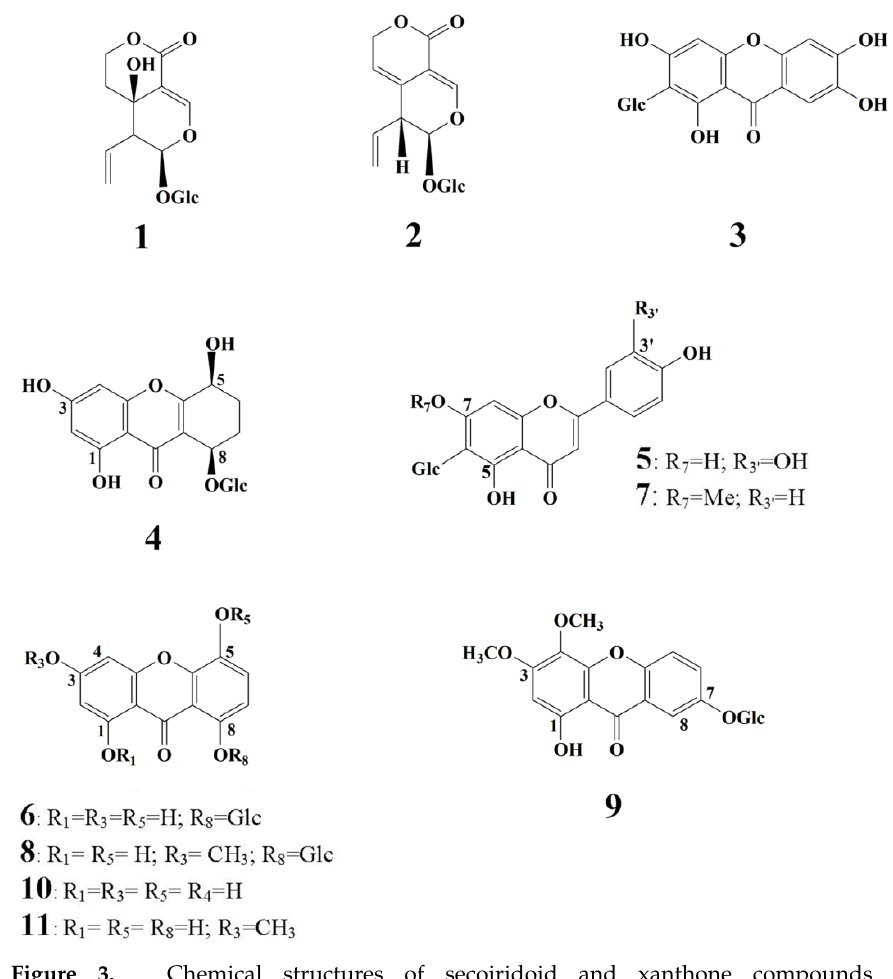
Figure 3. Chemical structures of secoiridoid and xanthone compounds identified in G. lutescens . 1 — swertiamarin, 2 —gentiopicrin, 3 —mangiferin, 4 —campestroside, 5 —isoorientin, 6 —deme- thylbellidifolin-8- O -glucoside, 7 —swertisin, 8 —bellidifolin-8- O -glucoside, 9 —veratriloside, 10 — demethylbellidifolin, 11